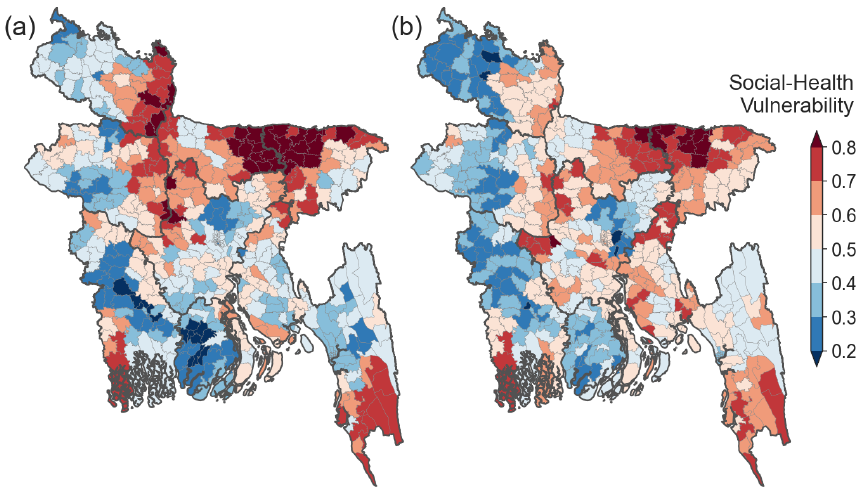
Figure 5. The SHV index score estimated by (a) the equal-weight and (b) PCA approaches.